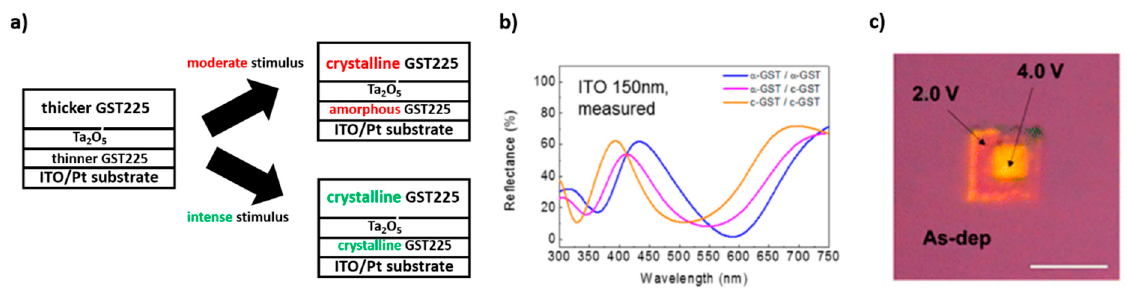
Figure 5. Examples of displays that can dynamically switch between more colors based on multilayered structures, which contain more than one layer made of a PCM. ( a ) Different PCM layers are characterized by different thicknesses and, as a consequence, different crystallization temperatures, so it is possible to achieve a selective crystallization of GST225 according to the intensity of the applied stimulus. Upon moderate heating or applied potential, only the thicker layer crystallizes, upon intense heating or applied potential both the GST225 layers crystallize; ( b ) measured reflectance spectra for 8 nm GST225/6 nm Ta 2 O 5 /5 nm GST225/150 nm ITO/Pt device upon different grades of stimulus and crystallization [35]; ( c ) optical microscope image (scale bar: 10 μ m) of the phase and color transition induced by applying different potentials [35]. Reproduced from Ref. [35] with permission from the American Chemical Society.